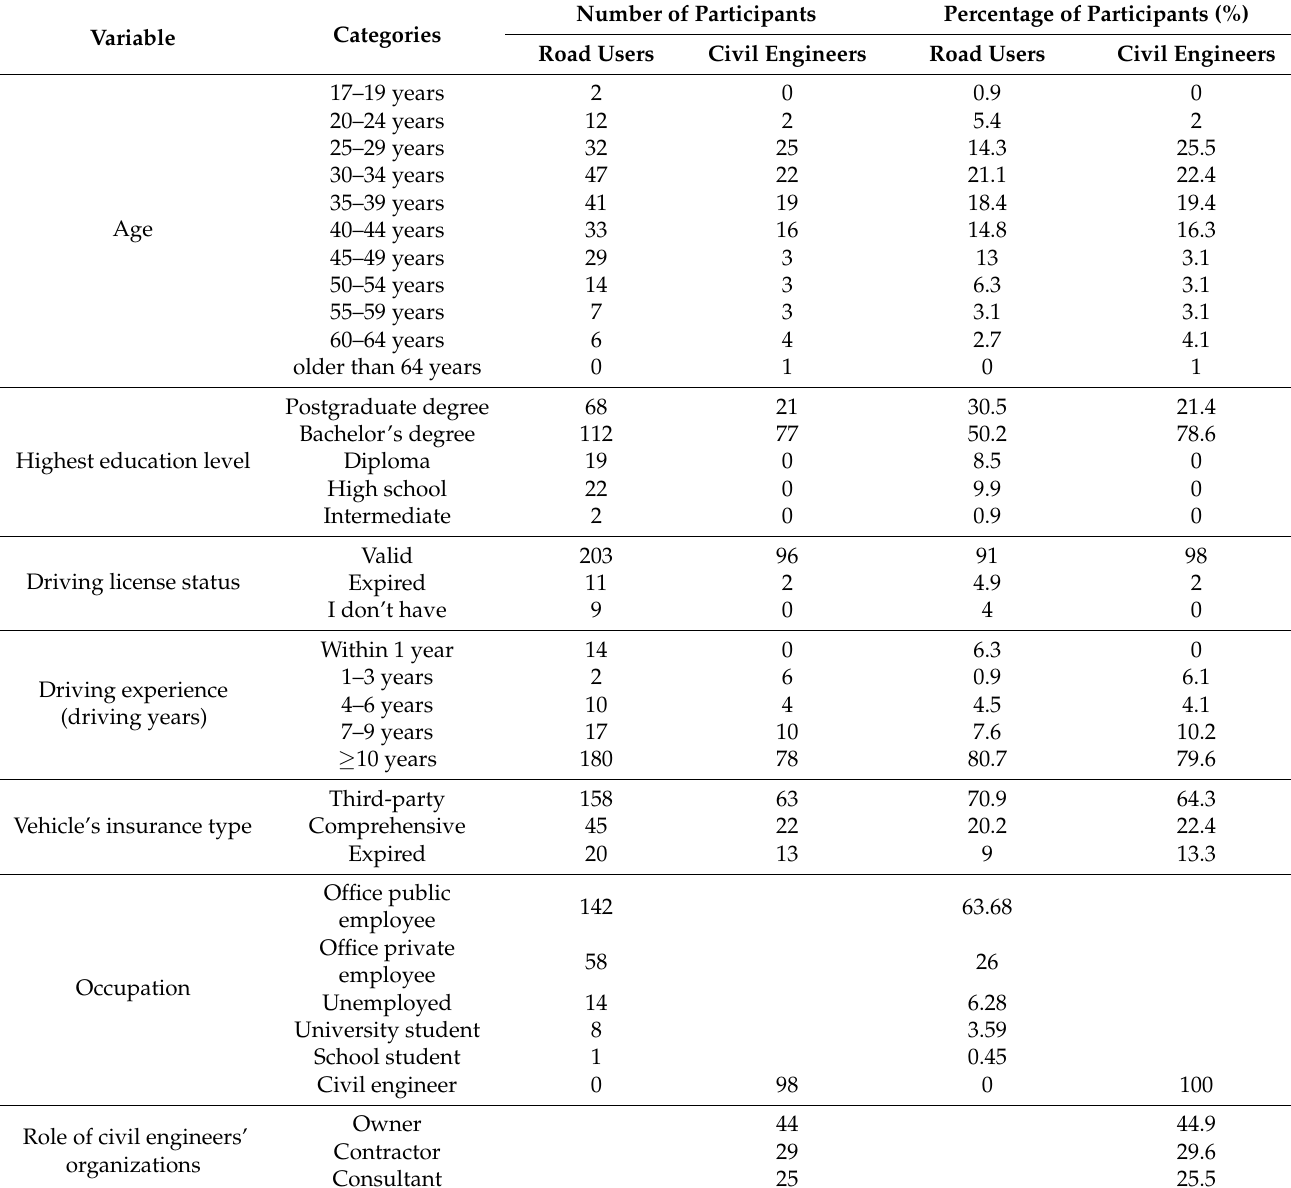
Table 1. Distribution of road users and civil engineers survey